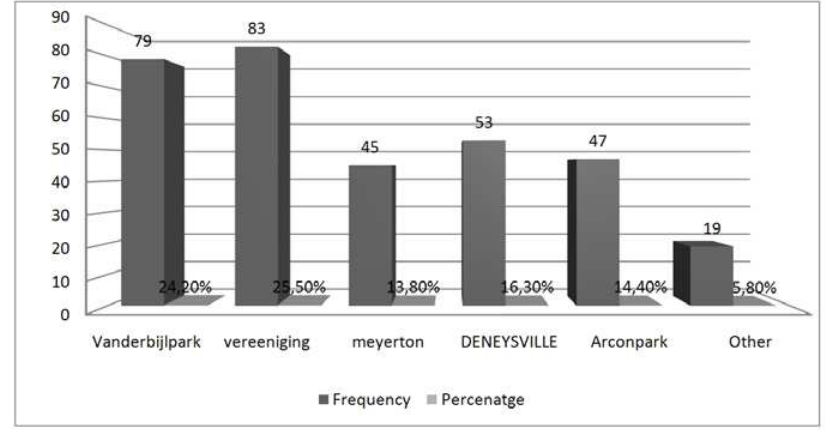
Fig. 2. Location of the